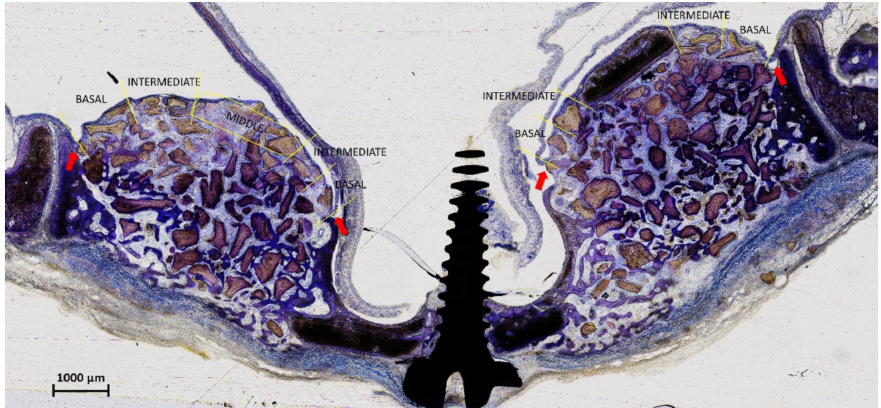
Figure 1. The sinus mucosa included between the sinus walls and the window displaced inward (inward window; IW) was divided into two parts, both at the lateral and medial sides: one part towards the bone walls (basal region) and the other part towards the IW (intermediate region). At the control site, the contour of the IW of the text site was drawn and superposed on a similar position at the control sites and similar regions to those selected at the test sites were identified. Moreover, in the control sites, also the region delimited by the superposed window contour was identified (middle region). Th red arrows indicate the mucosal folding region